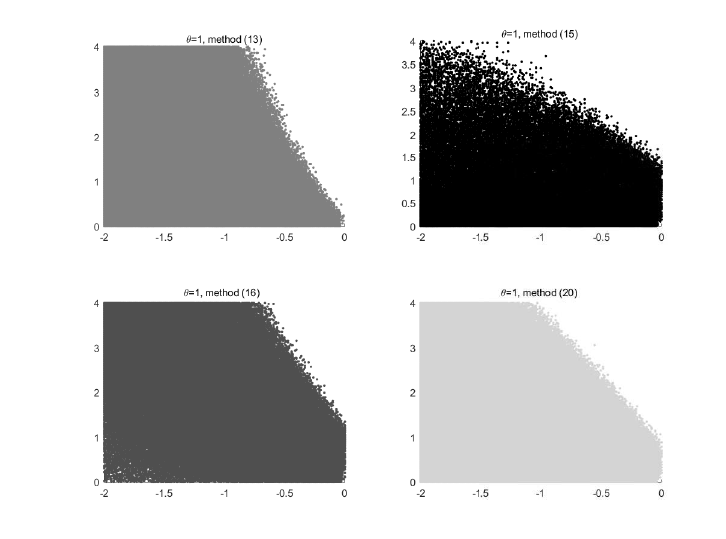
Figure 9. Asymptotic stability regions in the ( x , y )-plane with respect to the convolution test Equation (12) for z = − 2 and ϑ =